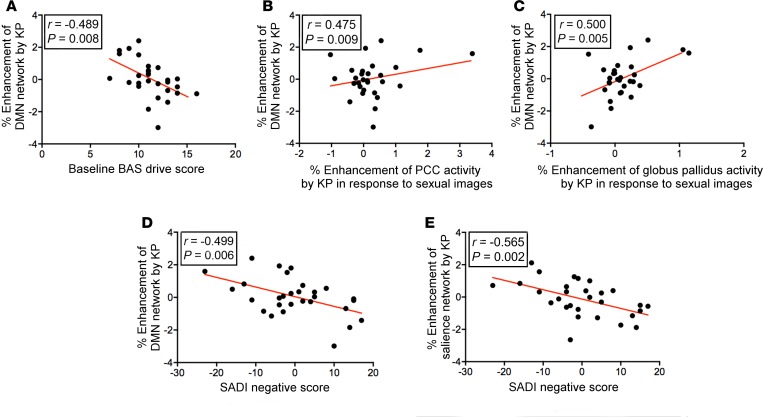
Kisspeptin (KP) modulates resting-state functional connectivity to enhance sexual brain processing and reduce sexual aversion.(A) KP administration enhances default mode network (DMN) connectivity more in participants with lower baseline drive reward scores (Behavioral Activation System [BAS] drive). (B) KP’s modulation of DMN connectivity correlates with subsequent increases in posterior cingulate cortex (PCC), and (C) globus pallidus activity in response to sexual images. (D and E) KP’s modulation of DMN (D) and salience network (E) connectivity correlates with reduced sexual aversion (Sexual Arousal and Desire Inventory–Negative). Two-tailed partial correlation testing, adjusted for visit order. n = 29 per group.